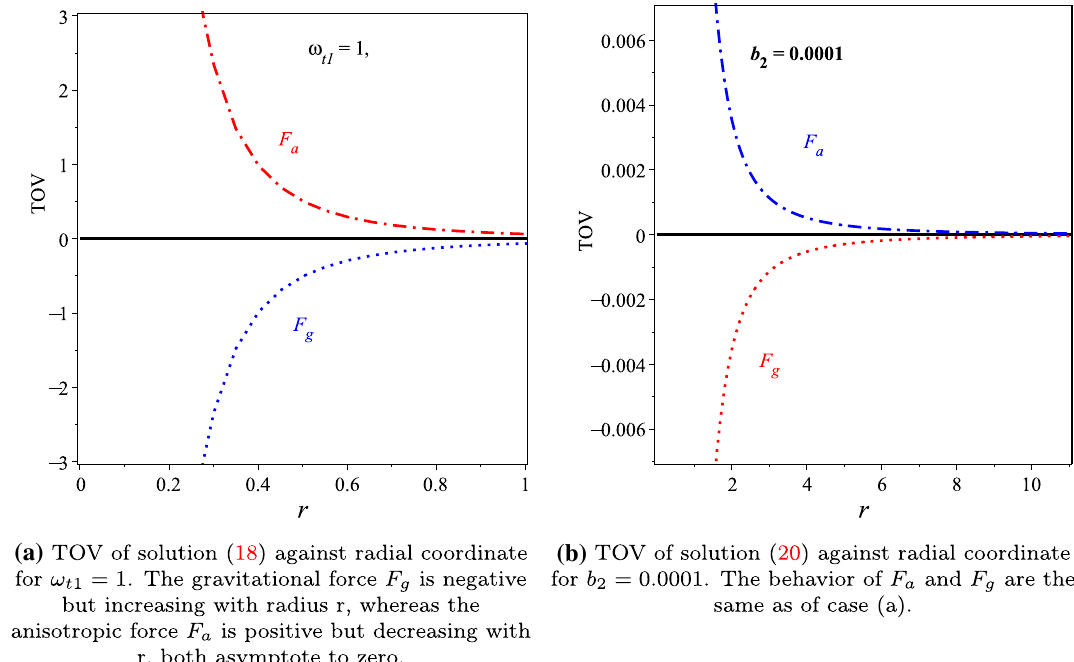
Fig. 7 TOV solutions (18) and (20) against r in km when b 0 = 0 . 0001 and b 1 = 0 . 01